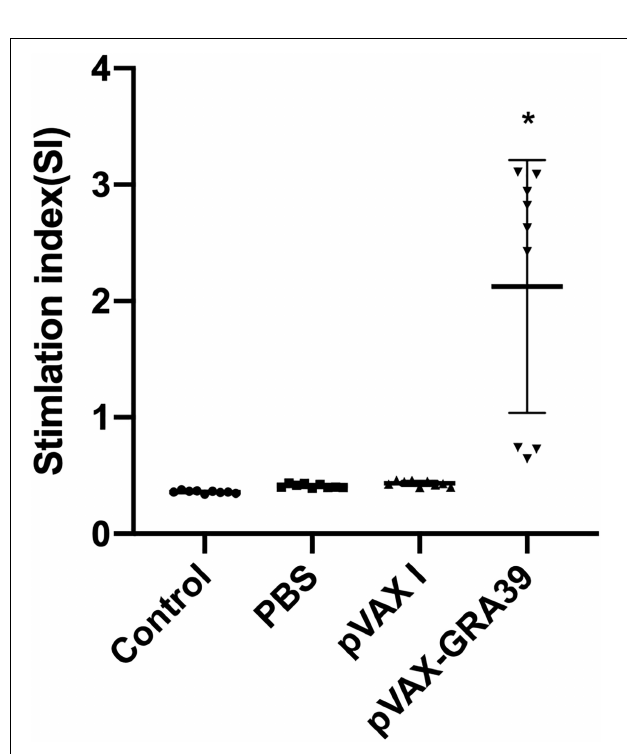
FIGURE 4 | Splenocyte proliferation assay. Two weeks after the last immunization, spleen lymphocytes were collected from vaccinated mice. The proliferative response was evaluated by MTT assay. The results are expressed as the stimulation index (SI) ± SD ( n = 3). Statistical differences are represented by * ( p <